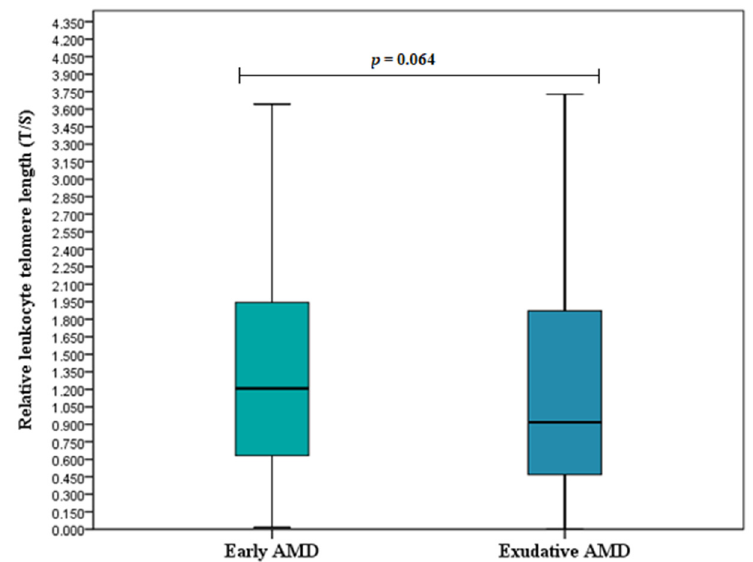
Figure 2. Relative leukocyte telomere length in exudative AMD patients and the control group II. Relative leukocyte telomere length (T/S) in exudative AMD patients versus healthy controls are pre- sented as box-and-whisker plots with the median and IQR. Mann–Whitney U test assessed T/S dif- ferences between patients with exudative AMD and control groups; p = 0.842.